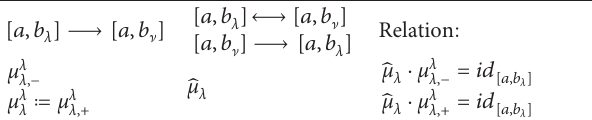
Table 1: The mappings in the first column are strictly ascending left and right continuous versions of ] λ while the mapping in the second column is absolute continuous and